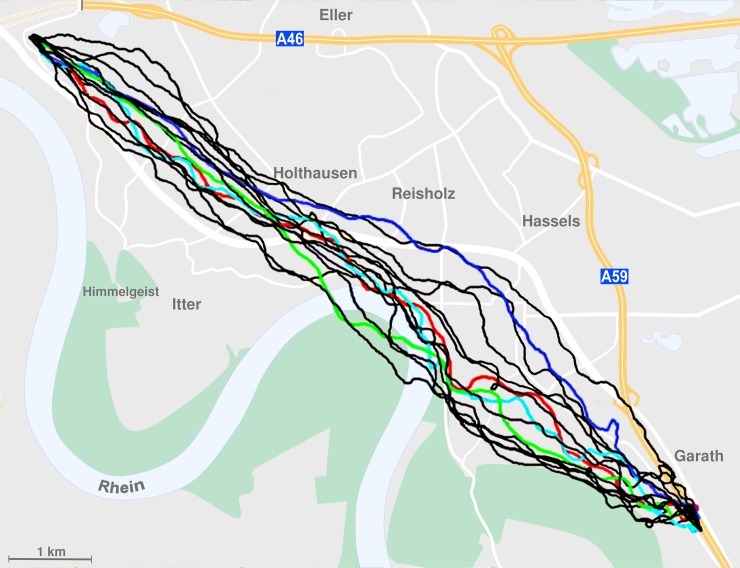
Map showing all solo, duo, and group flights of an unmated female.Black = solo flights; red, blue, green = 1st, 2nd, and 3rd duo flights; light blue = group flight.